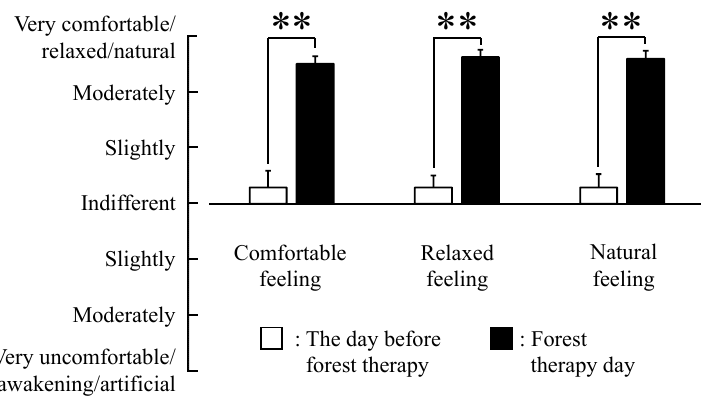
Figure 4. Semantic differential (SD) method scores for the day before forest therapy and immediately after forest therapy, showing changes in the subjective feelings “comfortable,” “relaxed,” and “natural”. N = 17, mean ± standard error. ** p < 0.01, Wilcoxon signed-rank test.